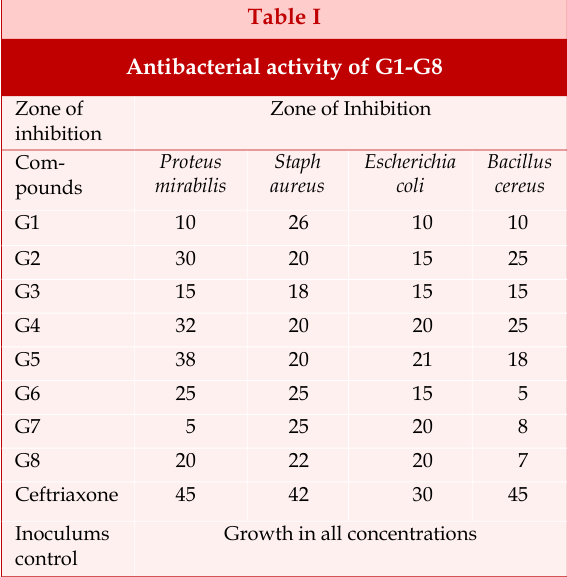
Antibacterial activity of